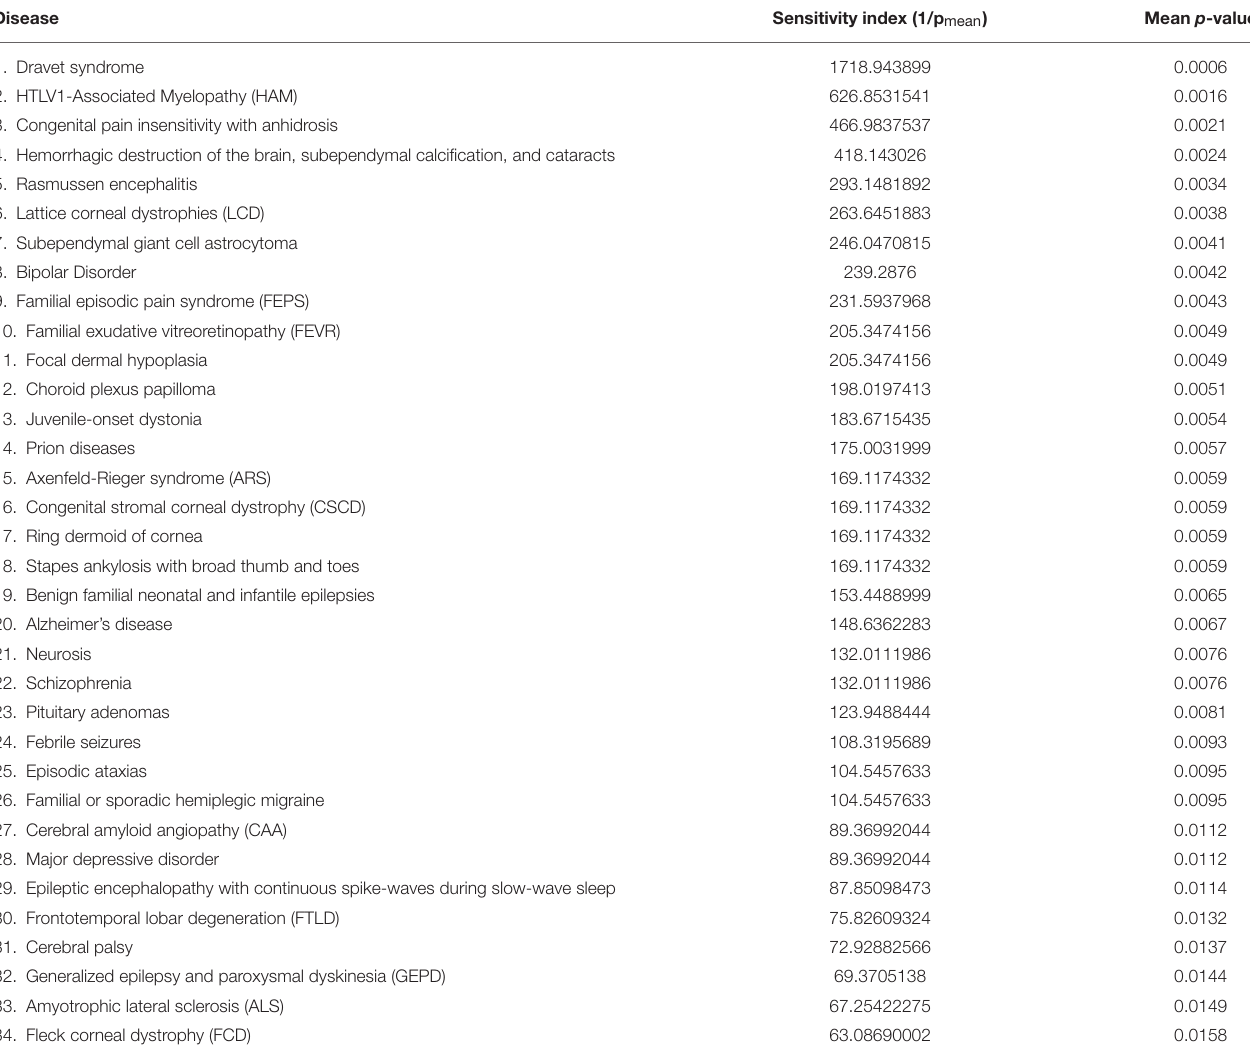
TABLE 2 | Top 34 neuron-related disease by lithium sensitivity.